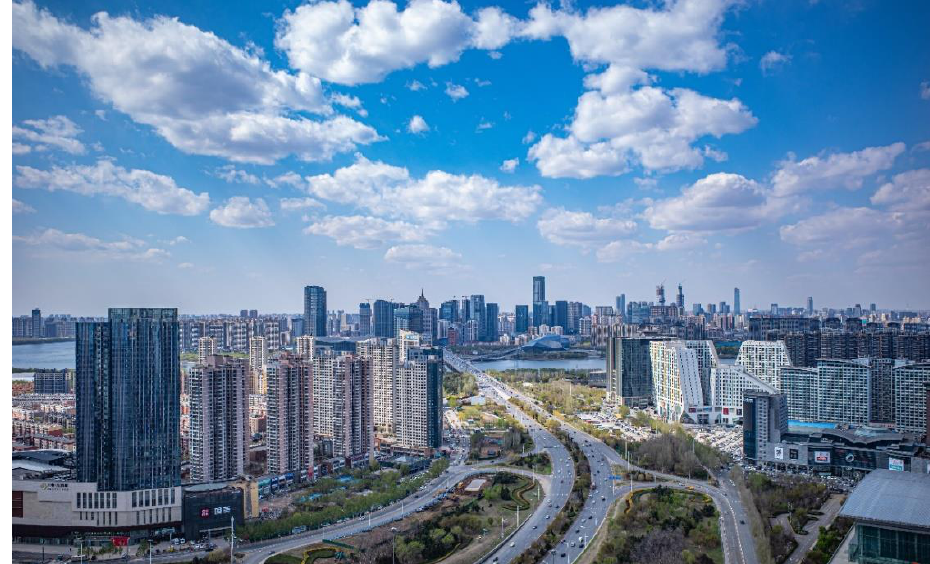
Figure 3. Visual accumulation of urban three-dimensional form from sample area L to sample area F. Source: Visual China Group.